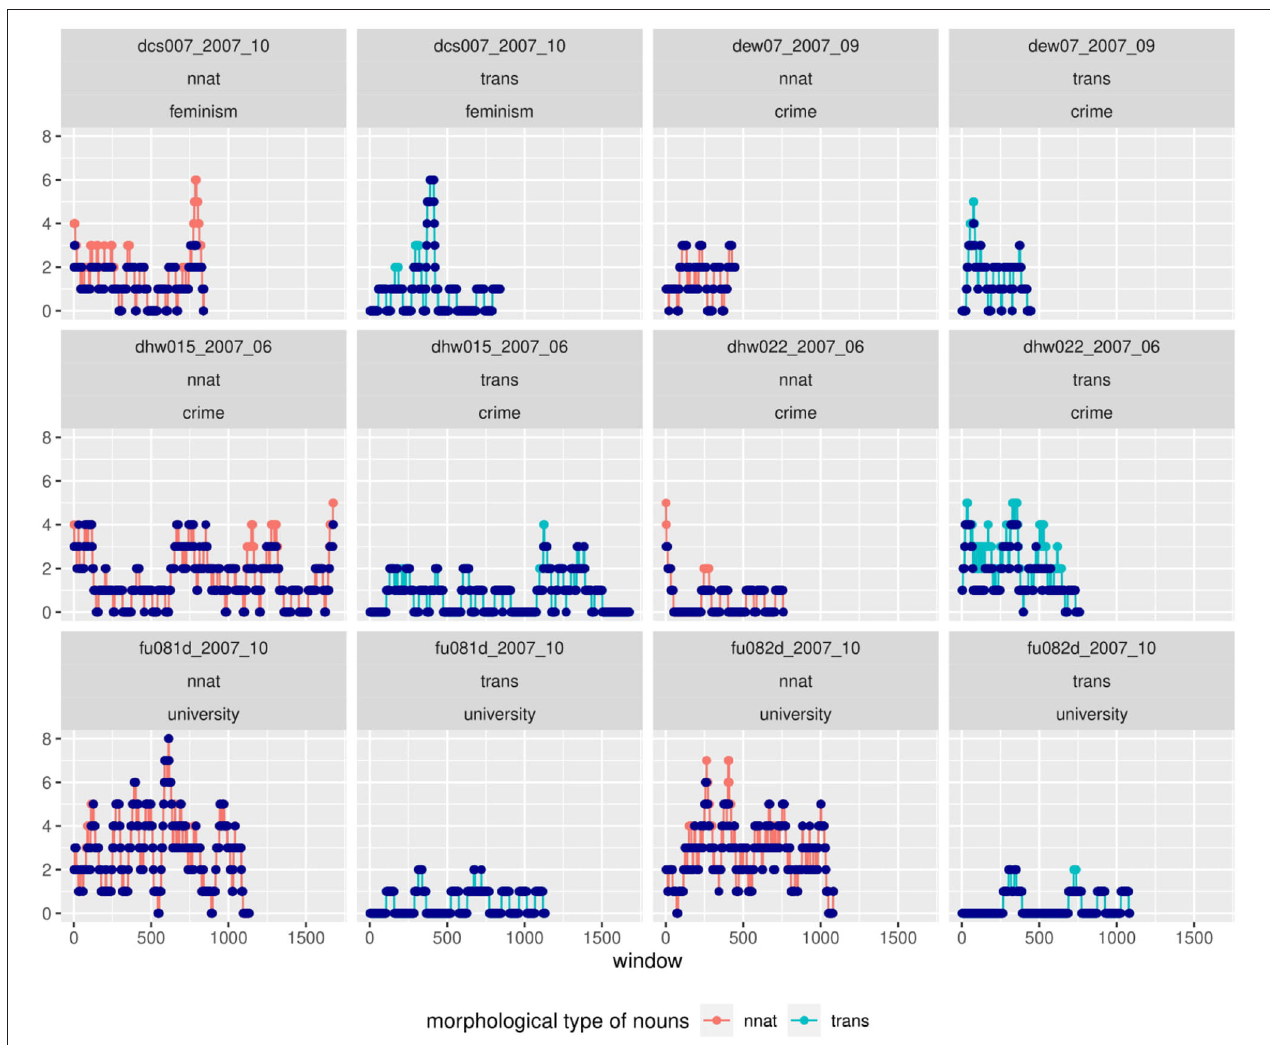
FIGURE 12 | A sliding-window analysis of nouns in Falko shows the clustering of categories in some, but not all texts. Morphological categories of nouns can strongly interact with topic, as in non-native nouns in the university topic. The repetition of lexemes within windows (suggestive of α -priming) is less likely than the introduction of new lexemes of the same